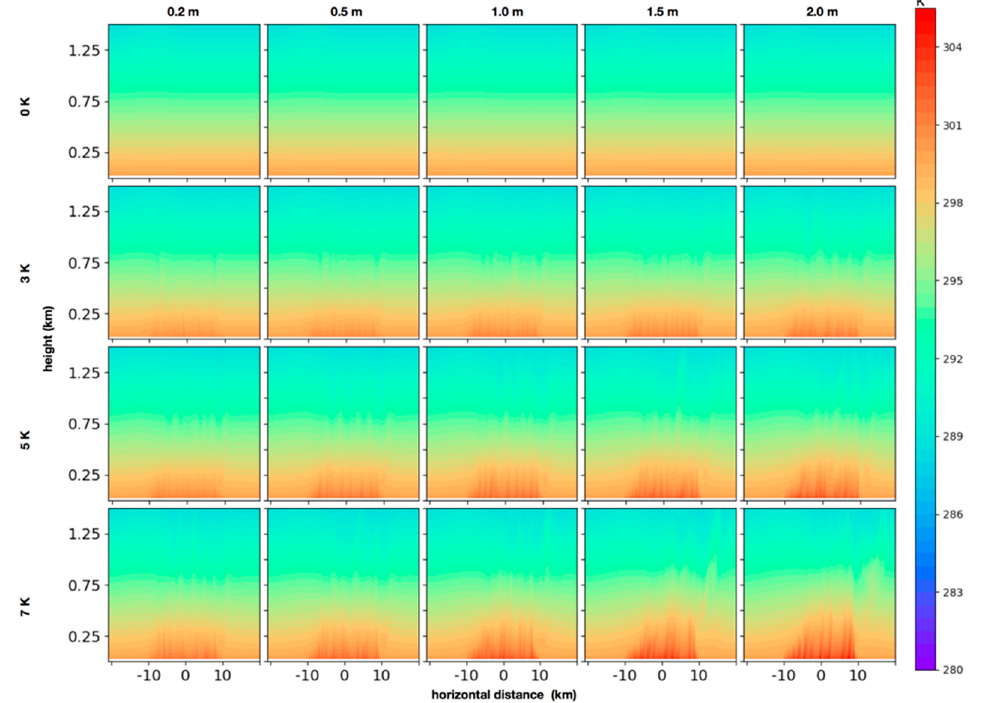
Figure 1. Cross-section of temperature (K) at t = 120 min. Each row represents simulations with a particular skin temperature perturbation within the idealized city while each column represents simulations with a particular z 0 value within the city.